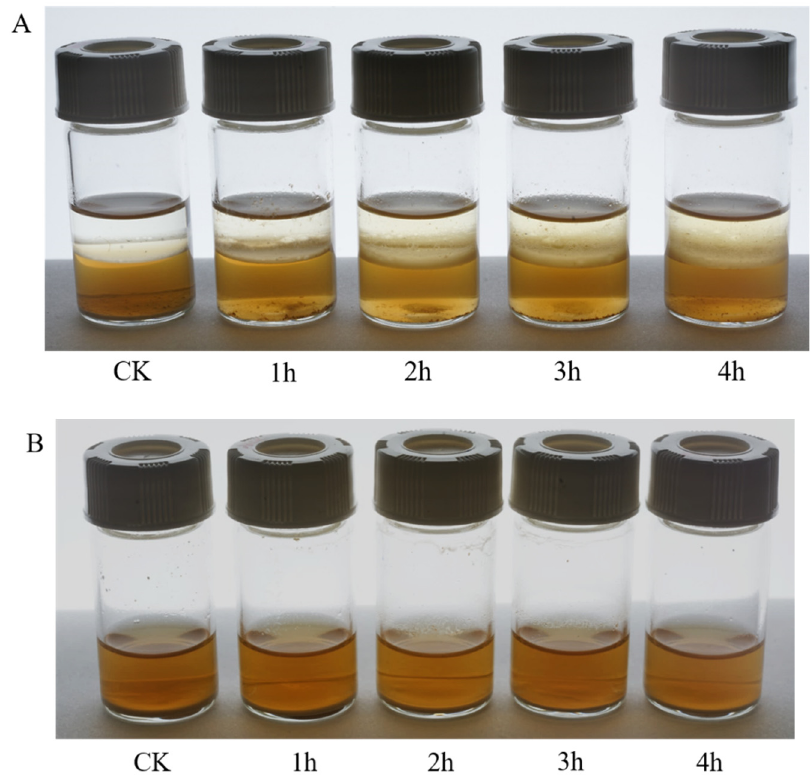
Figure 8. Conversion of polydatin into resveratrol by SpBGL1 in the biphase ( A ) and uniphase ( B ) conversion systems. Pictures were taken every hour after stopping agitation.